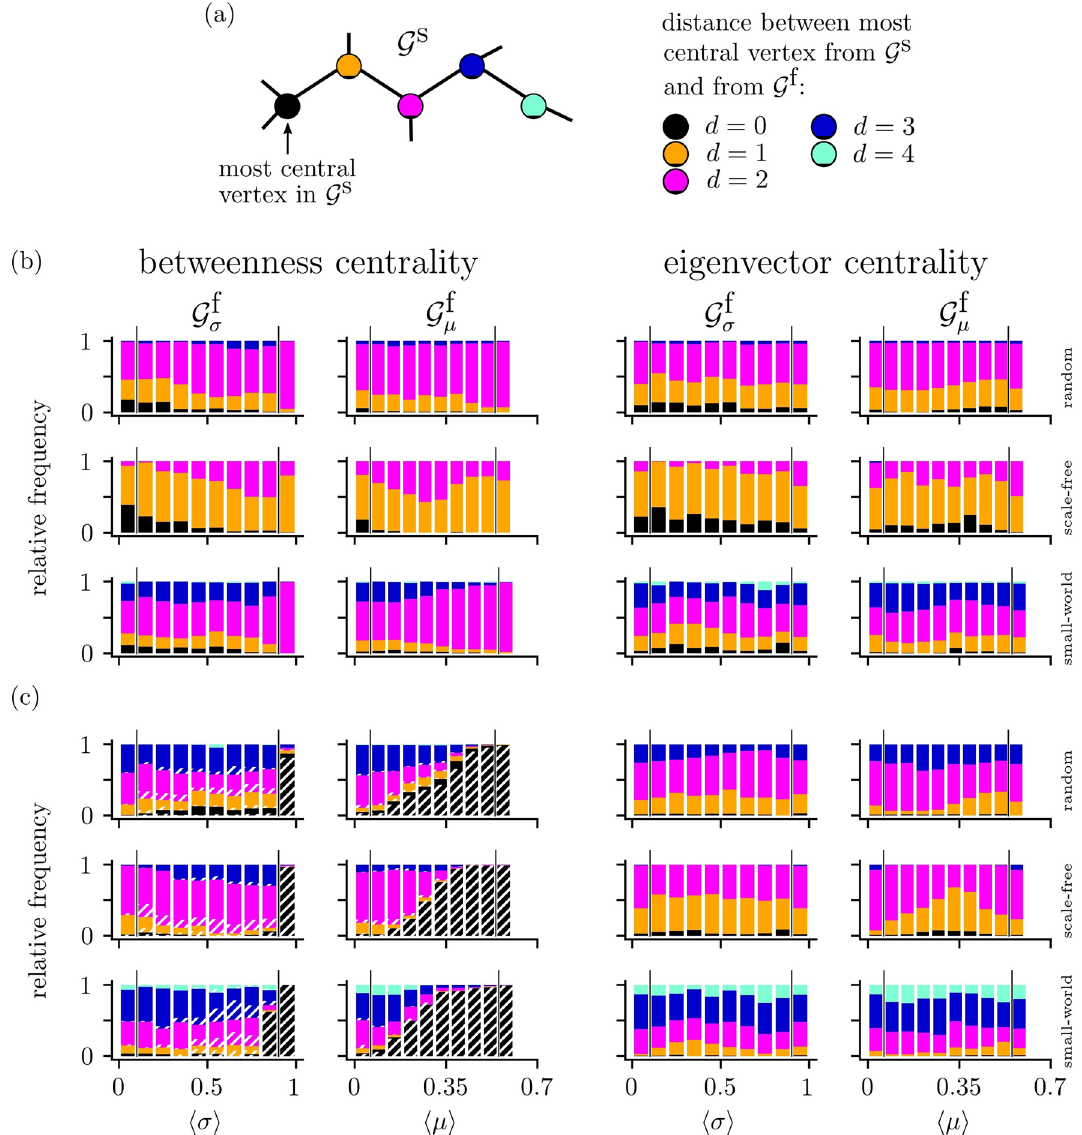
Figure 6. ( a ) Schematic of estimating the distance d between the most central constituents—here vertices— from a structural network G s and from a functional network G f . The coloring of a vertex indicates the distance between the most central vertex in G s and the most central one from a given realization of G f mapped onto G s . Coinciding most central constituents ( d = 0 ) are shown in black, most central constituents being nearest neighbors ( d = 1 ) in orange or being next-nearest neighbors ( d = 2 ) in pink. More distant central constituents are colored dark blue ( d = 3 ) or lightblue ( d ≥ 4 ). ( b , c ) Stacked histograms of the relative frequency of distances between the most central vertex ( b )/edge ( c ) from G f and the most central constituent from the corresponding G s depending on average strength of interactions. Coloring as in ( a ). Hatched bars indicate functional networks G f , for which a most central constituent could not be identified unambiguously. Black vertical lines between the bars indicate borders between regimes I and II and between regimes II and